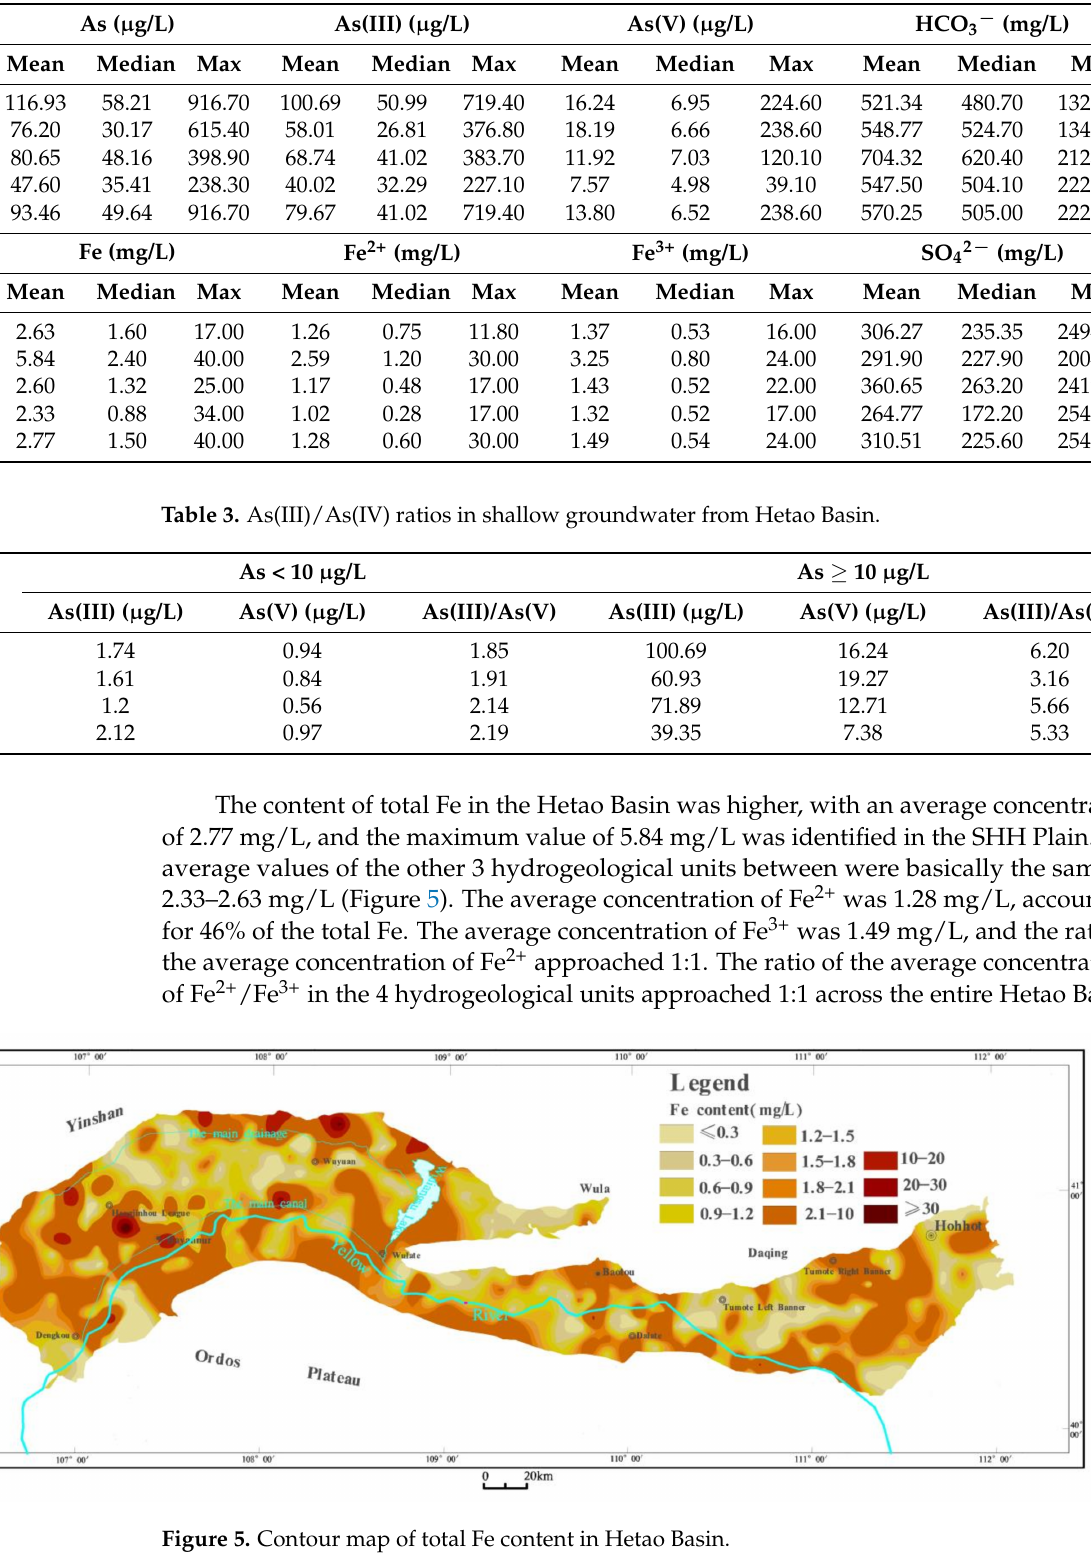
Figure 5. Contour map of total Fe content in Hetao